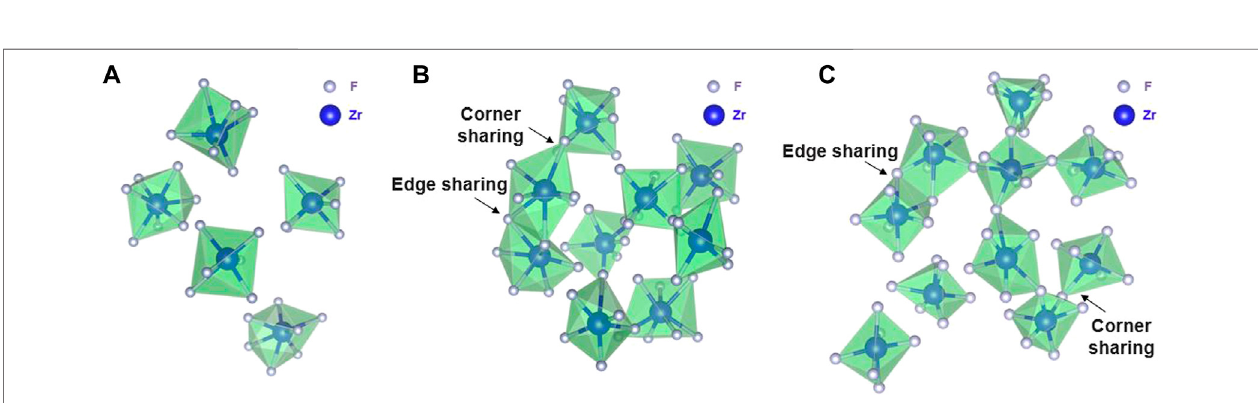
FIGURE 7 | Snapshots from AIMD calculations showing (A) no chain formation in Composition A at 750 ° C, (B) a short fl uorozirconate chain ([ZrF x4 − x ] n ) in Composition B at 727 ° C, and (C) a long fl uorozirconate chain ([ZrF x4 − x ] n ) in Composition C at 700 ° C. Chain is created by edge and corner-sharing among 6-, 7-, and 8- fold coordinated fl uorine zirconium complexes. Na, Li, and “ free ” fl uorine atoms are removed during visualization.